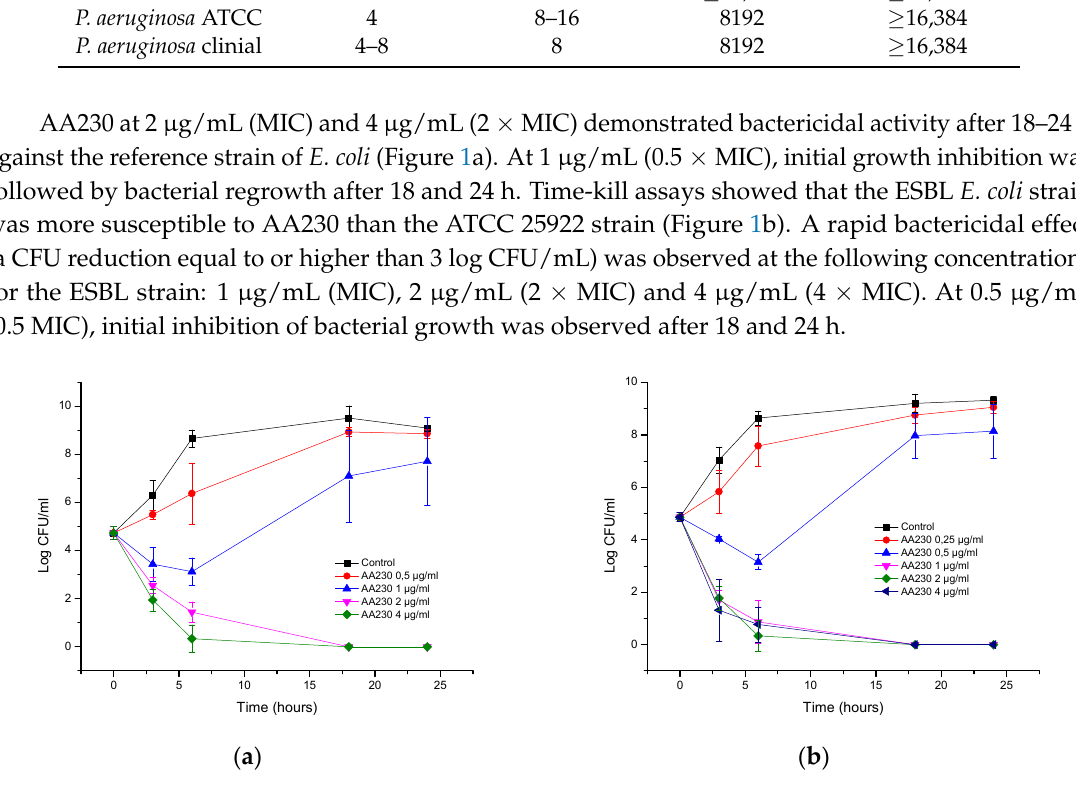
Figure 1. Time-kill curves of antimicrobial peptide AA230 against ( a ) Escherichia coli ATCC (American Type Culture Collection); ( b ) Escherichia coli ESBL (extended spectrum beta lactamase).